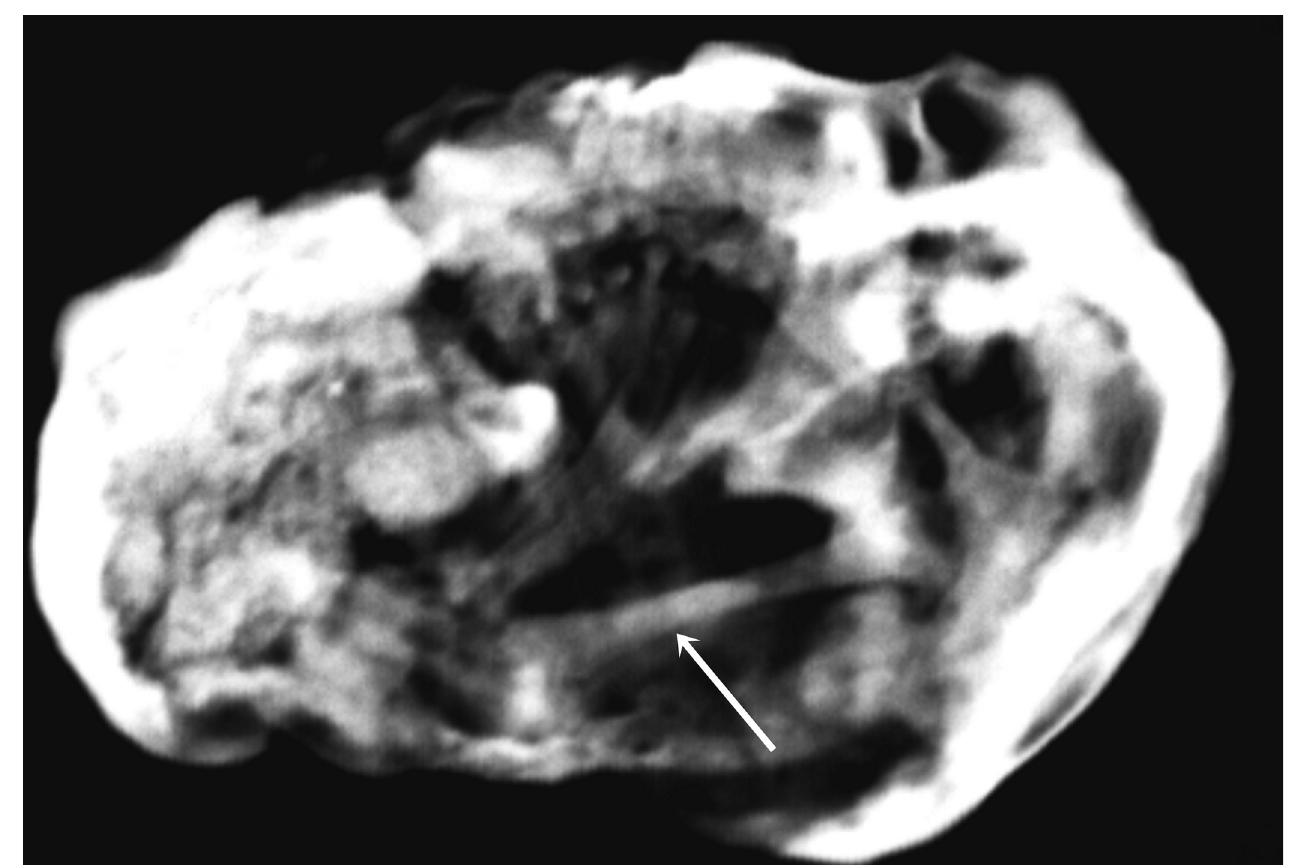
Fig 4. X-ray imaging of the inside of the cyst. The arrow marks the femur.